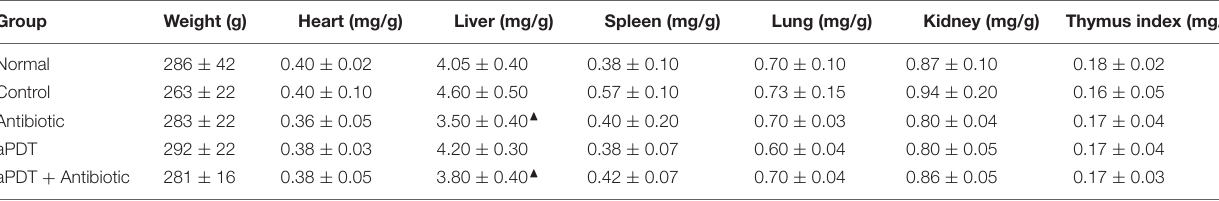
TABLE 5 | The organ index in rats after treatment. Group Weight (g) Heart (mg/g) Liver (mg/g) Spleen (mg/g) Lung (mg/g) Kidney (mg/g) Thymus index (mg/g)